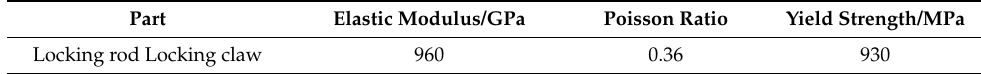
Figure 6. Locking rod stress distribution. Table 1. Mechanical properties of components.